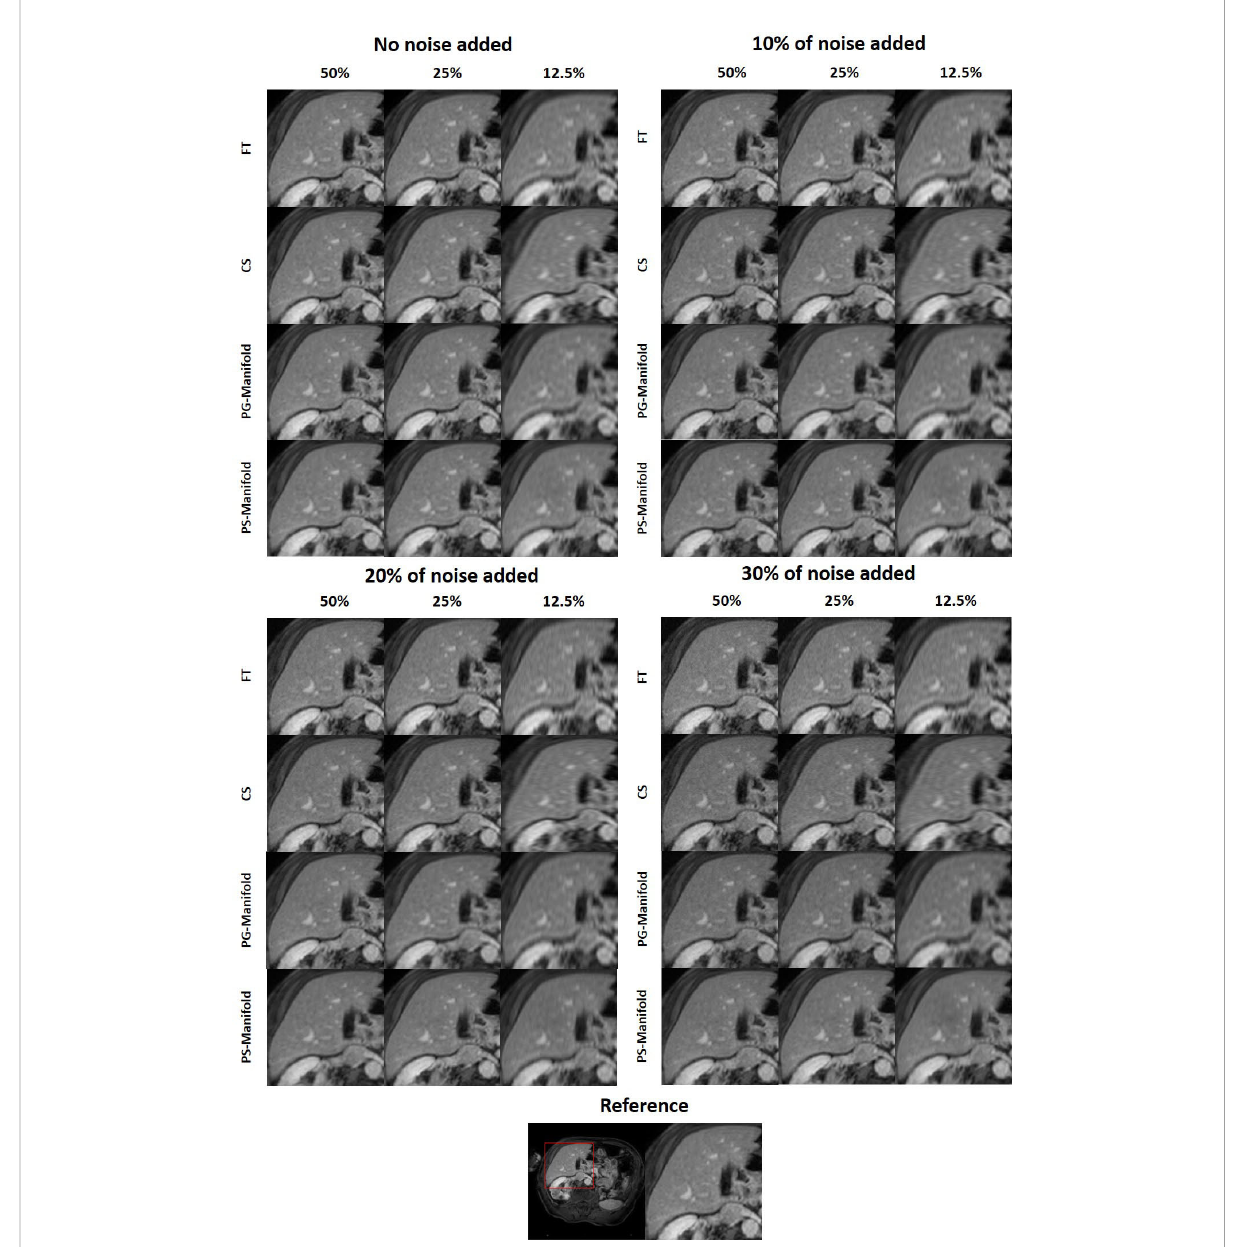
FIGURE 8 Reconstruction results of a patient case using data with different undersampling ratios and noise levels. The complete reference image and the zoomed-in patches are displayed in a window of [0,